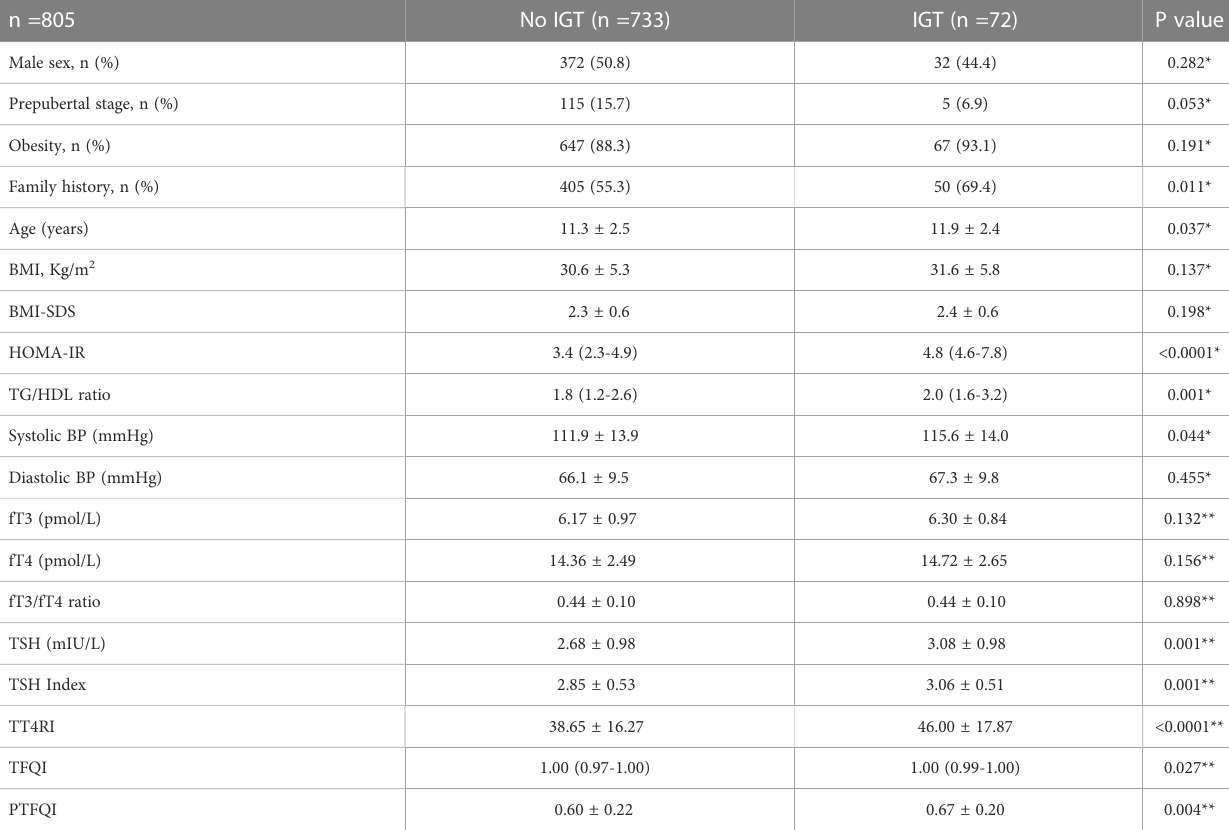
TABLE 2 Anthropometric, clinical, biochemical and thyroid variables by IGT.